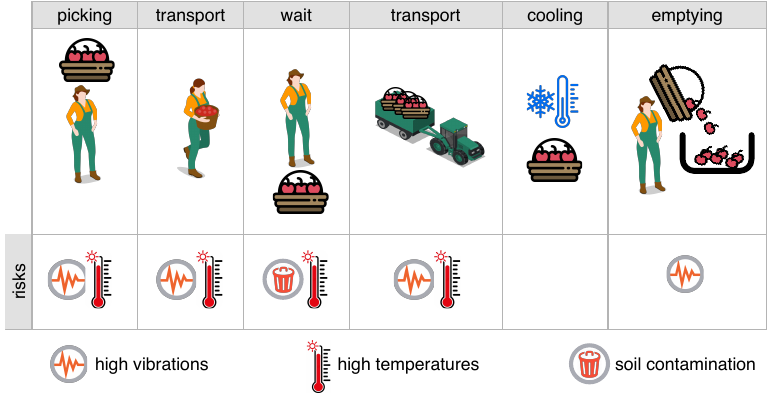
Figure 1. The harvest process and the risks that can affect the shelf life of the